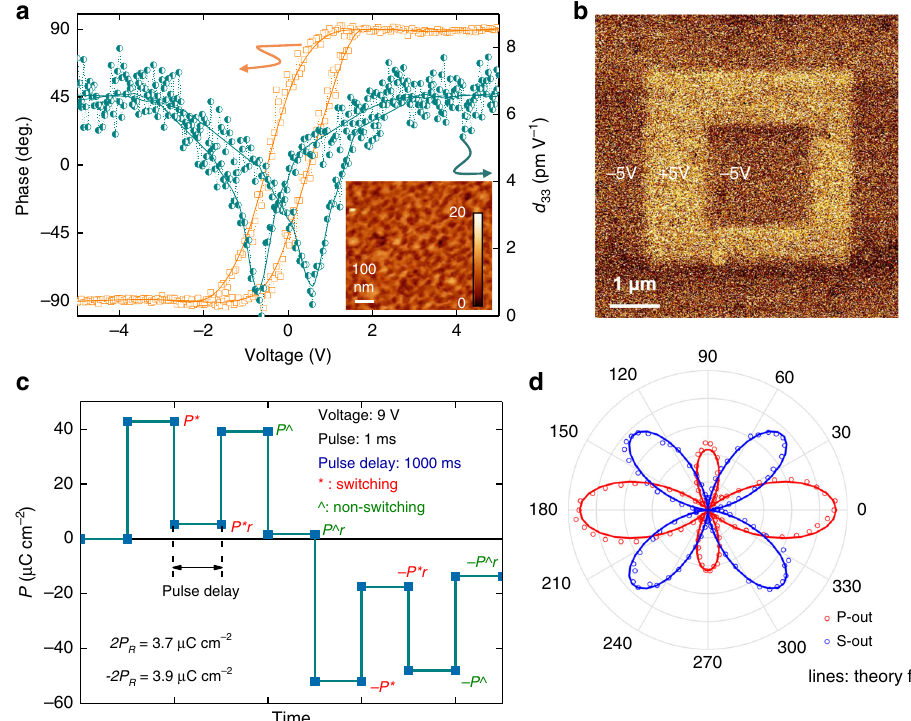
Fig. 2 Intrinsic ferroelectricity for ~100 nm thick VAN SMO:BSO fi lms at RT. a Piezo-hysteresis response measured by PFM. Amplitude (circle and blue) and phase (square and red) of the PFM signal as a function of bias voltage. The inset AFM image shows the surface morphology of the fi lm. b PFM phase contrast after − 5 V writing (6× 6 µ m 2 ), 5 V rewriting (4 ×4 µ m 2 ) and − 5V rewriting (2 × 2 µ m 2 ) at RT. The phase contrast remains after 24h. c PUND measurements with 9 V ( E = 500 kVcm − 1 ), 1ms pulse width and 1000ms pulse delays for capturing both switching (*) and non-switching (^) polarisations. The net switching polarisation, 2 P R , is ≈ 3.9 μ C cm − 2 and is consistent with P R obtained from P-E hysteresis. d Optical SHG signals at RT. Red and blue points represent p-wave and s-wave of the second harmonic electric fi eld. The incidence angle is 45°. The solid line is a theoretical fi t of the SHG